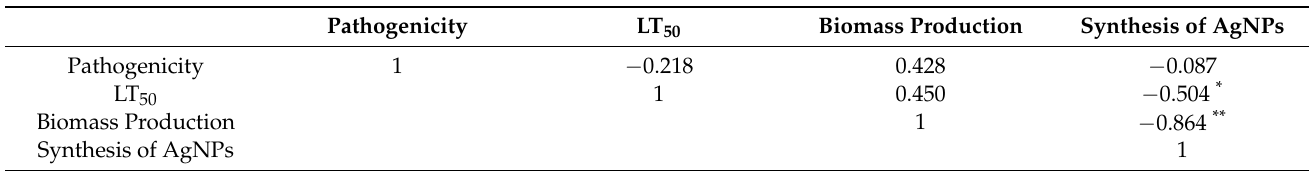
Table 4. Coefficients of Pearson’s correlation ( r ) between biological parameters (pathogenicity, LT 50 , and biomass production) and silver nanoparticle synthesis potential with entomopathogenic fungi extracts.